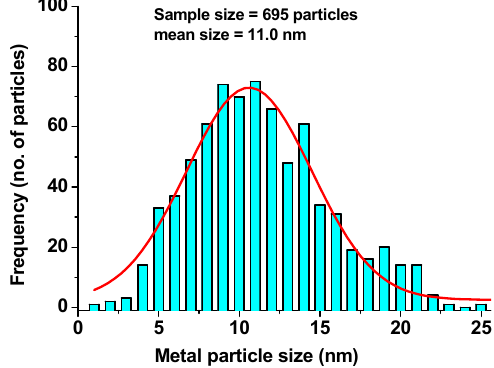
Figure 2. Normal metal particle ‐ size distribution of the fresh Co/C catalyst by TEM analysis. Figure 3. Normal metal particle-size distribution of the fresh Co/C catalyst by TEM analysis. Catalysts 2017 , 7 , 69